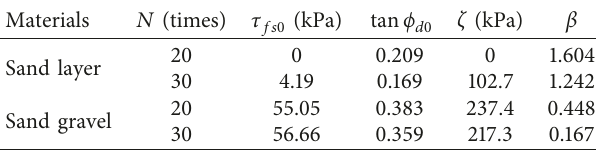
Table 4: Parameters of cyclic shear